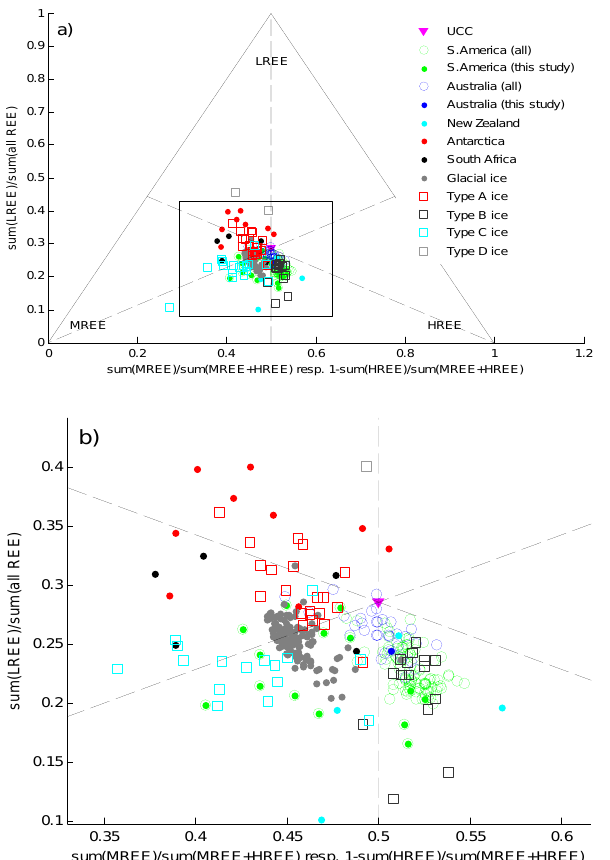
Fig. 7. Plot of the ratios of LREE, MREE and HREE of crust- normalized concentrations. The PSA samples are indicated as fol- lows: South America: green dots, southeastern Australia: blue dots (for Australia and South America, the samples for this study ( < 5µm) are indicated with circles around the dots), Antarctica: red dots, southern Africa: black dots, New Zealand: light blue dots. Glacial EDML samples are indicated with grey dots. All other ice core samples are represented by squares: Type A red, Type B dark grey, Type C light blue, Type D light grey. See Fig. 3 and the text for a description of the different types. The crossing point of the dashed lines indicates the normalized UCC composition (magenta triangle). The glacial samples are clearly located in the area covered by the South American samples: (a) complete overview, (b) zoom of the central box.